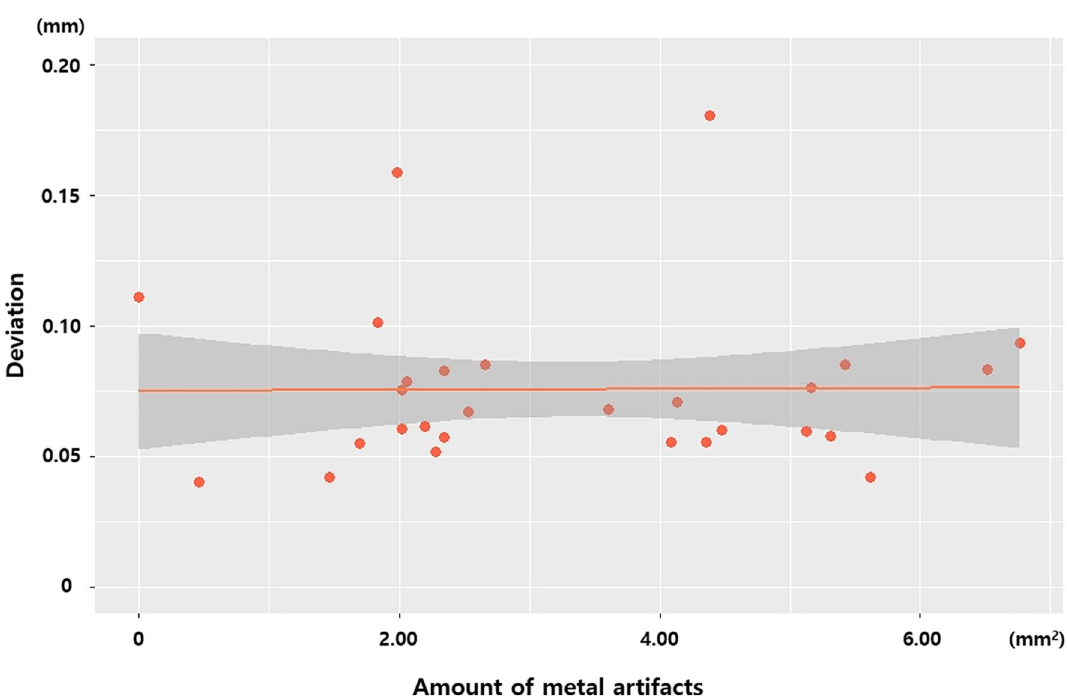
Figure 4. Scatter plot showing the correlation between the deviation (mm) of the MAR-applied model and the amount of metal artifact (mm 2 ). No meaningful correlation is